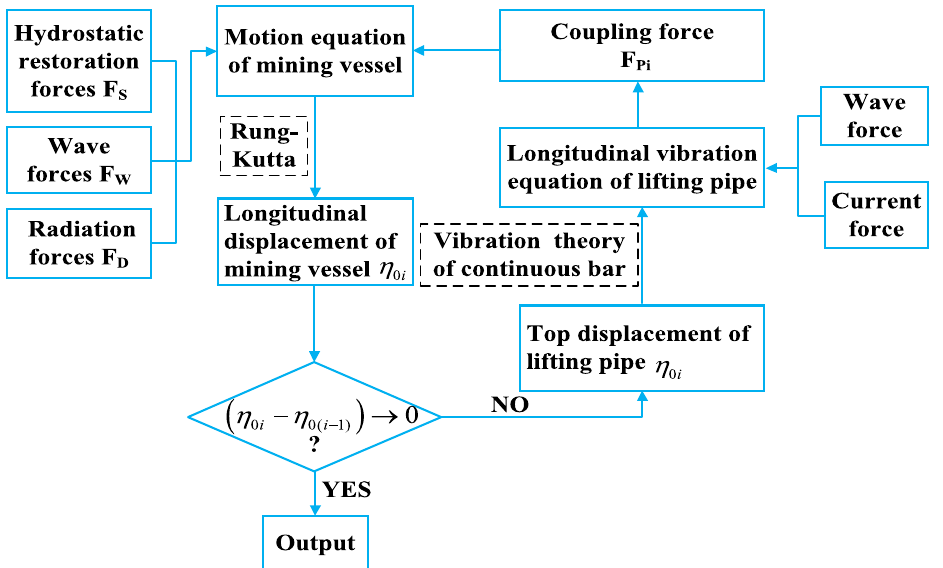
Figure 5. Flow chart of numerical calculation of coupled model (created by Microsoft Visio 2019 software, URL: https:// www. micro softs tore. com. cn/ visio/ visio- stand ard-